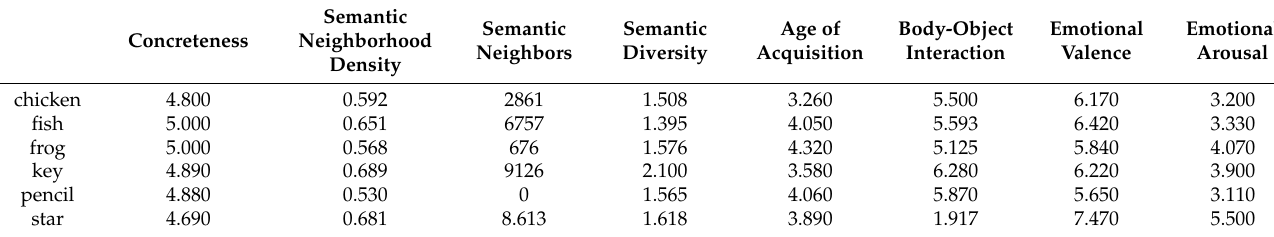
Table 1. Psycholinguistic semantic properties of 6 stimuli in the study (This information is available at the English Project Lexicon website: https://elexicon.wustl.edu/, accessed on 28 June 2021). Semantic Semantic Semantic Age of Body-Object Emotional Emotional Concreteness Neighborhood Neighbors Diversity Acquisition Interaction Valence Arousal Density chicken